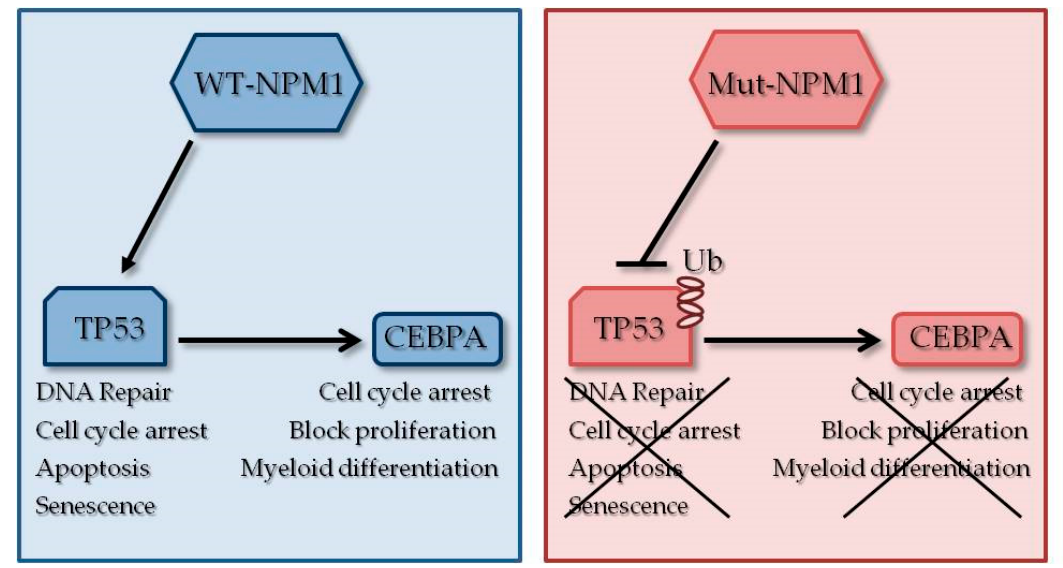
Figure 3. Relevant mutated non-epigenetic tumor suppressors in AML. This scheme highlights proteins’ interaction and pathway deregulation in AML blast with known tumor suppressors mutations. The blue panel shows, in detail, the positive interplay involving wild-type NPM1, increase in TP53 stability (via Mdm2 ubiquitin-ligase activity inhibition) and in CEBPA activity. The red panel shows how, in presence of mutated NPM1, TP53 is highly ubiquitinated, degraded and is unable to activate CEBPA.